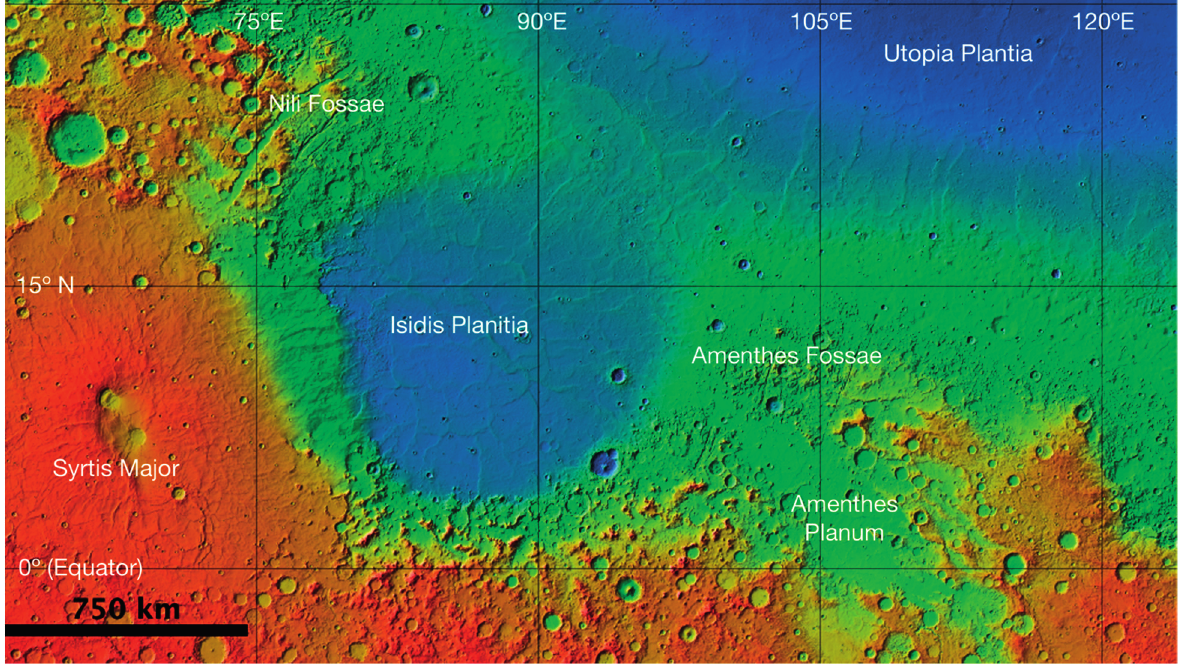
Figure 1. Context geomorphological map of the study area. Colors indicate elevations, with blue hues representing lowlands and yellow-red hues representing highlands. Isidis Planitia is center-left in the figure. The nomenclature and locations of Utopia Planitia,